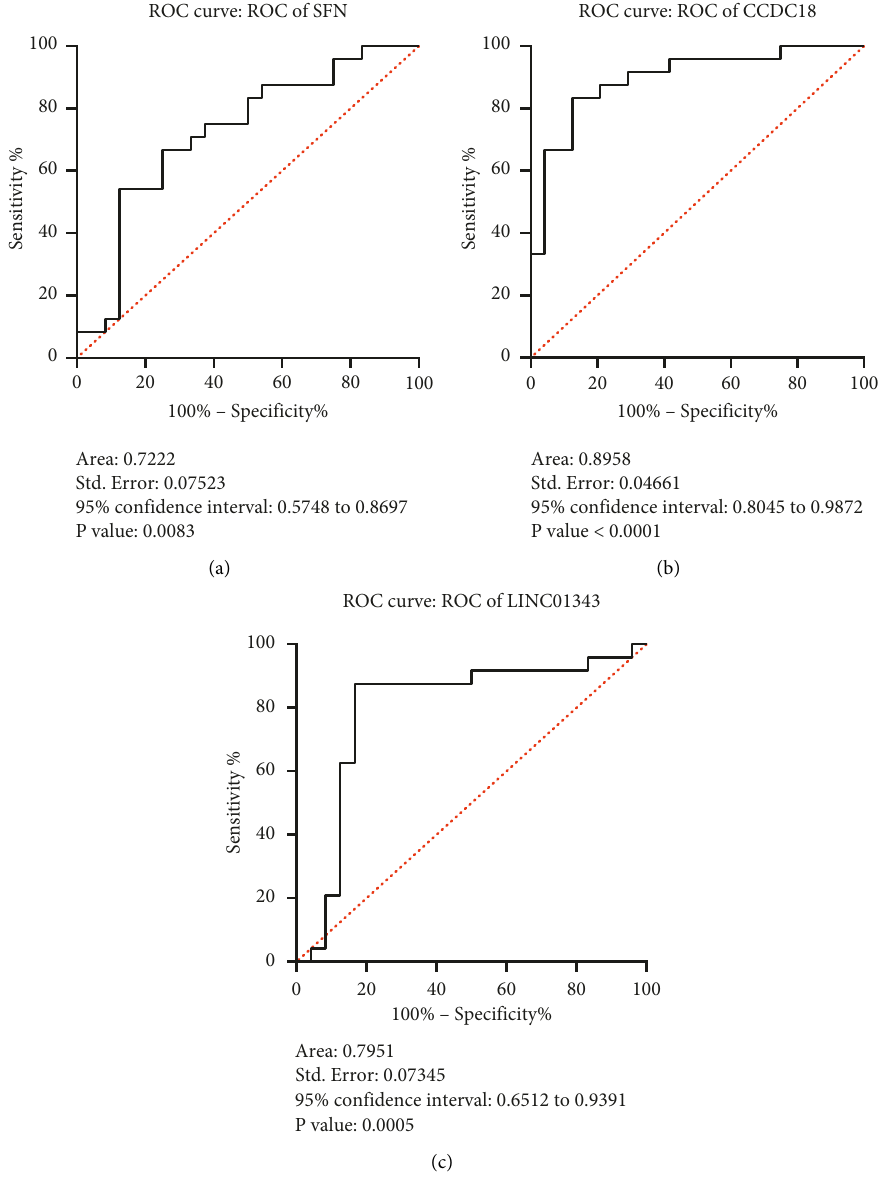
Figure 5: The ROC curve of sensitivity versus specificity of SFN , LINC01343, and CCDC18-AS1 in BC based on their expression resulting from qRT-PCR was constructed by GraphPad. In these plots, an excellent model with AUC near 1 has a good measure of